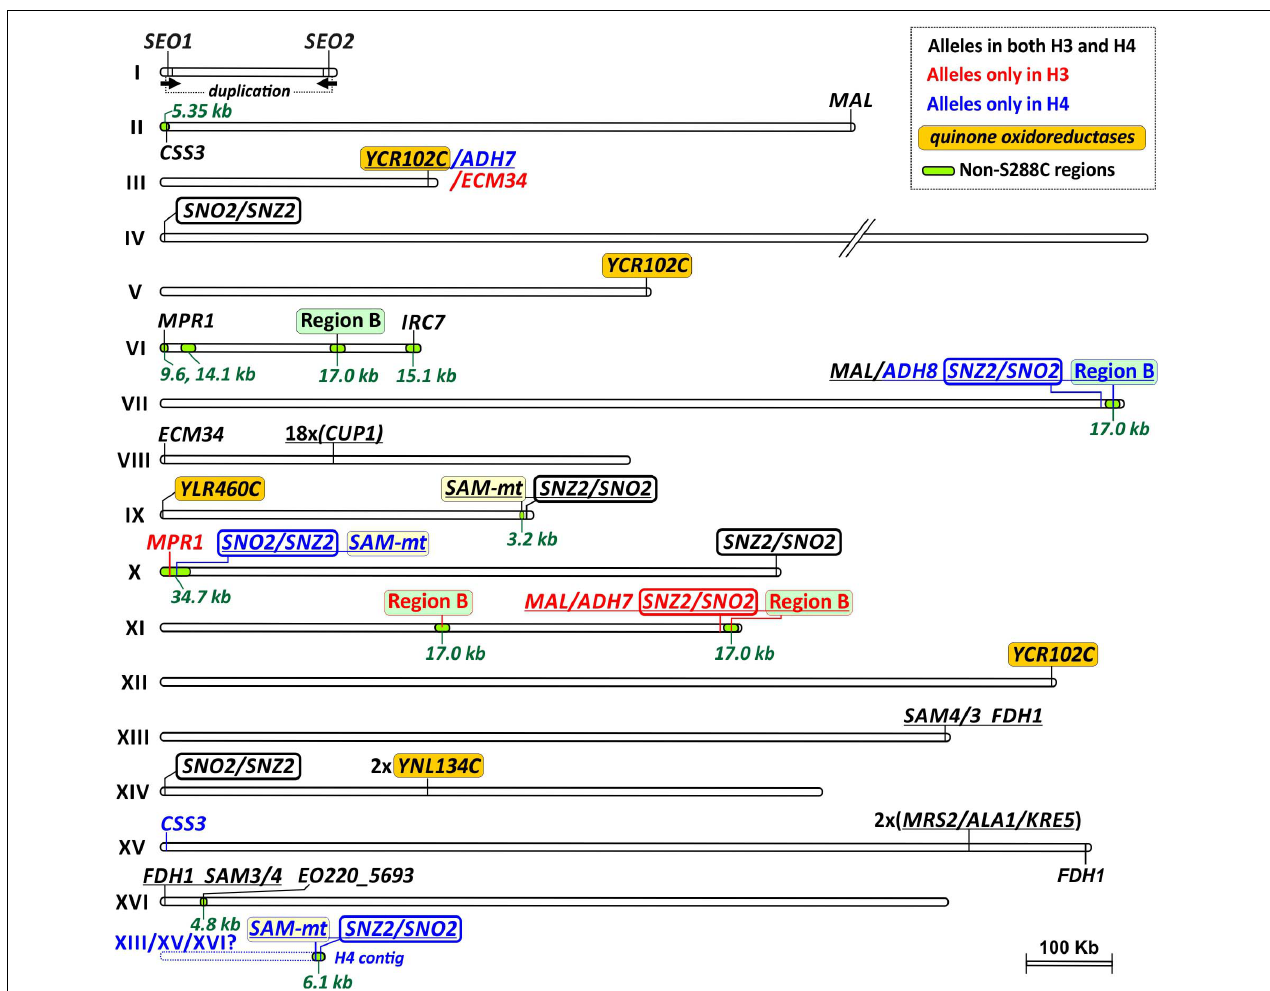
FIGURE 1 | Chromosomic map of H3 and H4 showing regions with increased copy numbers when compared to the reference S288C. Loci present in H3 and H4 that are absent from S288C are also displayed as green regions overlaying chromosome structures. The gene content of each labeled region is schematically depicted on the Figure 2 . The sixteen chromosomes are shown in scale with the exception of a shortened (//) version of the Chr. IV. An unplaced subtelomeric region of the H4 genome (corresponding to a single H4 contig), which contains the SAM-m t and SNZ2 / SNO2 locus, is depicted below the Chr. XVI and has a putative location downstream the FDH1 region (its uncertain location at either one of the Chrs. XIII, XV, or XVI is indicated by a question mark). Regions and genes present in both H3 and H4 genomes are labeled in black. Regions and genes present only in H3 have their labels colored in red, while those exclusive to H4 are displayed in blue. Four key multi-copy regions are highlighted by colored boxes framing their labels. They correspond to genes of the quinone oxireductase family (orange box), Region B (green box), SAM-dependent methyltransferases ( SAM-mt , yellow), and the cluster SNO2(3) / SNZ2(3) (box with thick